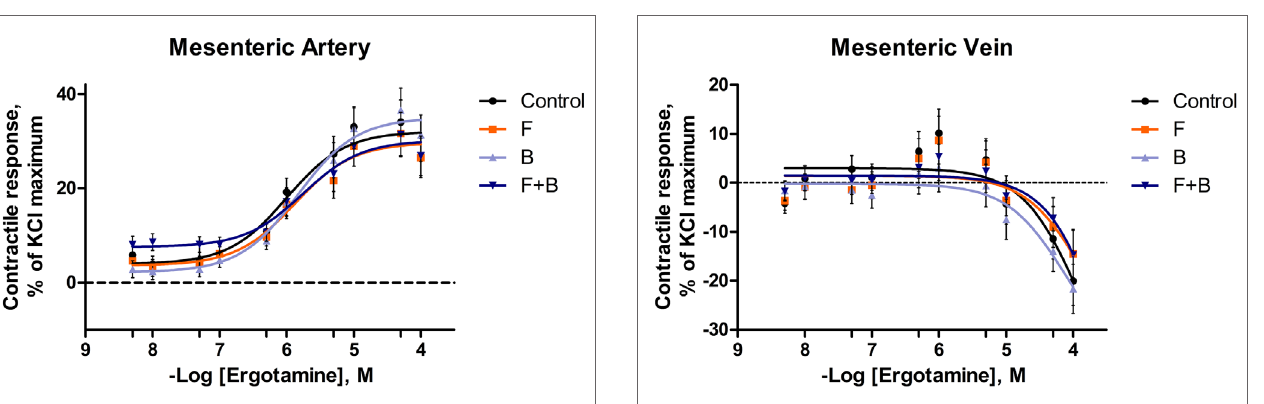
FigUre 3 | Mean contractile response, as % Kcl maximum of mesenteric vein to increasing concentrations of ergotamine for pretreatments without tall fescue seed extract: only Krebs– henseleit buffer (control); 1 × 10 − 6 M formononetin ( F ); or 1 × 10 − 6 M biochanin a ( B ); and combination of 1 × 10 − 6 M F and 1   response. EC 50 is the molar concentration of ergotamine inducing 50% of the KCl maximum response.